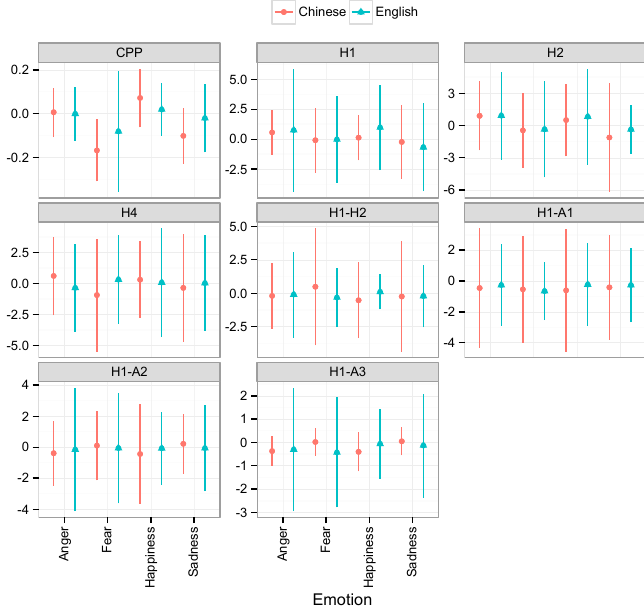
Figure 4. Phonation-related acoustic measures of four emotions in Mandarin and English. Points indicate mean values and error bars 95% confidence intervals (Adapted from Figure 2 in Reference [31]).